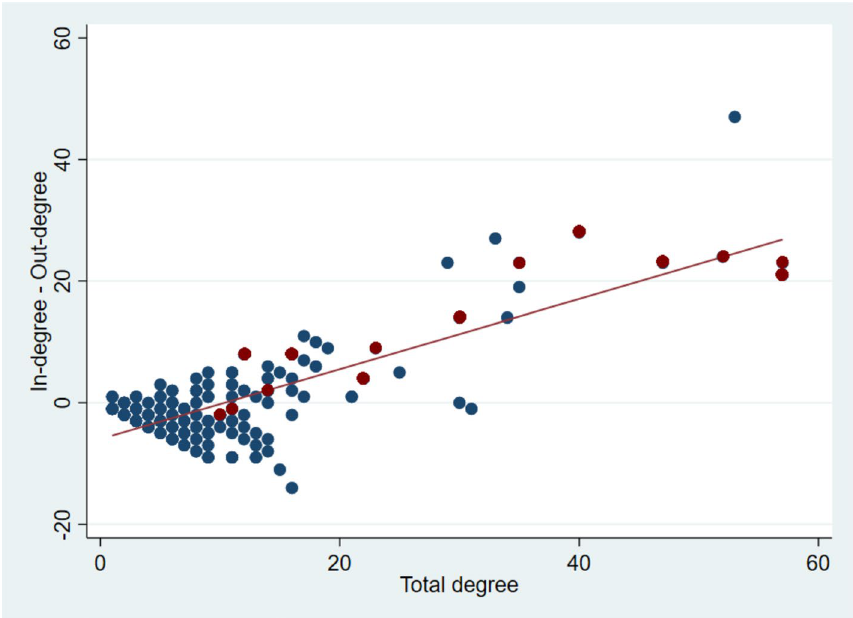
Figure 4. The net connectivity of nodes. Most base (“receiver”) hospitals (in red) have positive traffic (in-degree > out-degree), whereas some “distributor” hospitals have negative traffic. A total degree is the sum of in-degree and